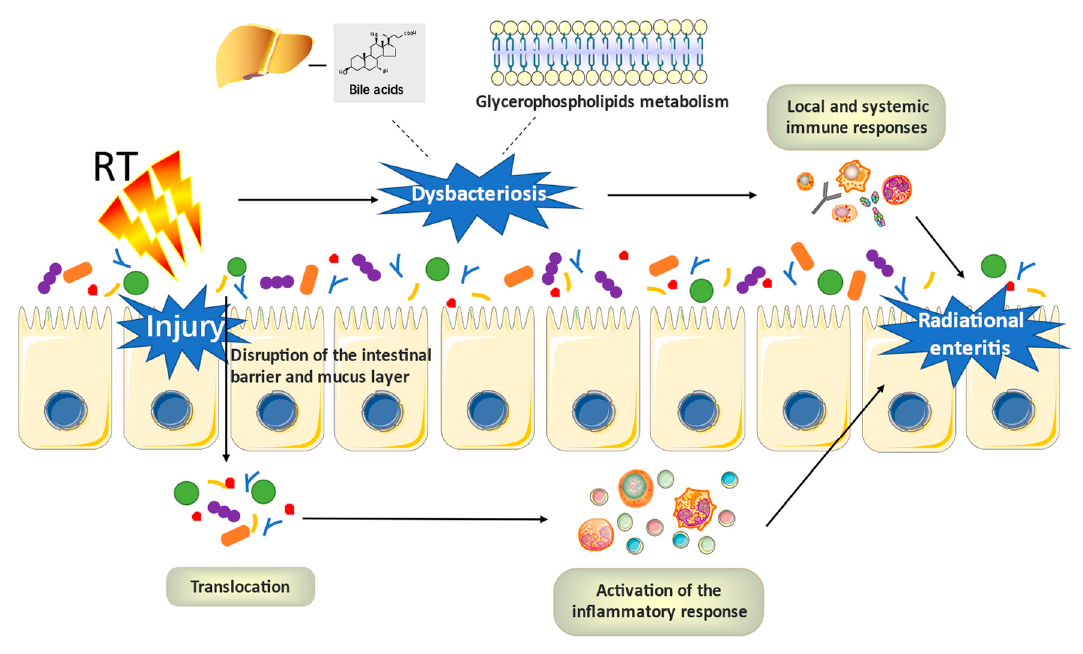
Figure 2. The potential mechanisms of radiation enteritis associated with gut microbiota.